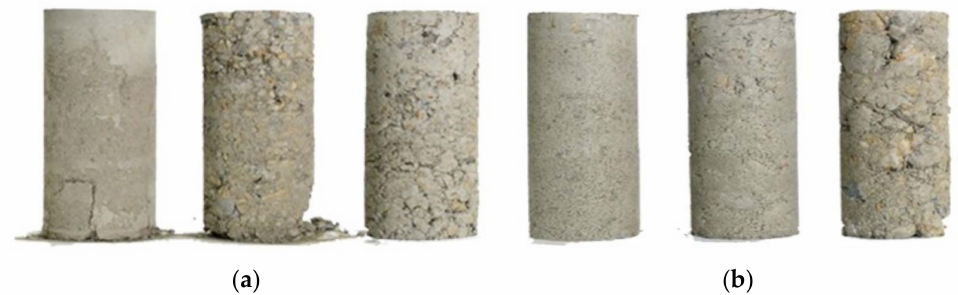
Figure 3. Sample appearance before failure: ( a ) compaction, kneading, and static (from left to right); ( b ) soil particles <#4, #4–3/4”, and >3/4” (from left to